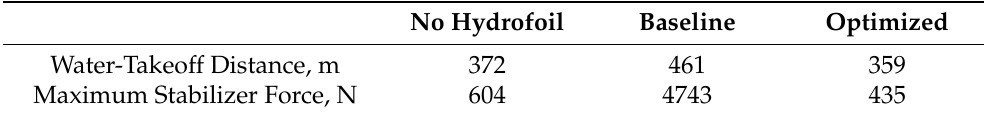
Figure 20. Aircraft drawing with baseline and optimized hydrofoil configurations (in meters). Table 7. Water-takeoff performance results and comparisons between the different